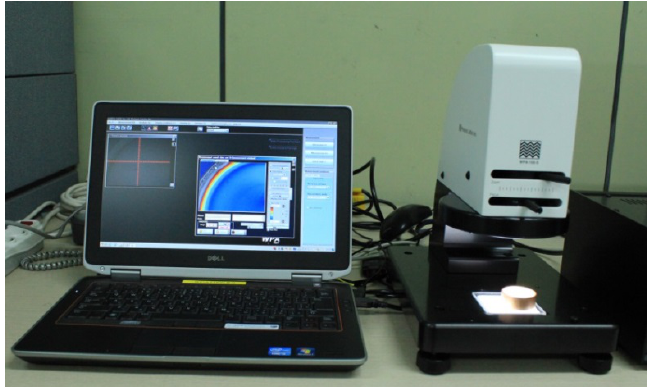
Figure 9. Polarimeter system for measuring residual stresses in silicone